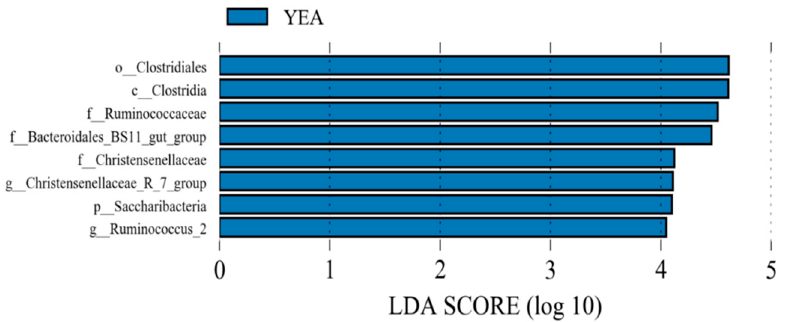
Figure 2. Linear discriminant analysis effect size of rumen bacterial populations of beef steer fed no (control) or 15 g/d of live yeast product (YEA; PMI, Arden Hills, MN, USA). This plot indicates the most differentially abundant taxa according to the logarithmic linear discriminant analysis (LDA) score cutoff of ≥ 4.0. All the taxa meeting the significant threshold of 4.0 are enriched in steers fed YEA.